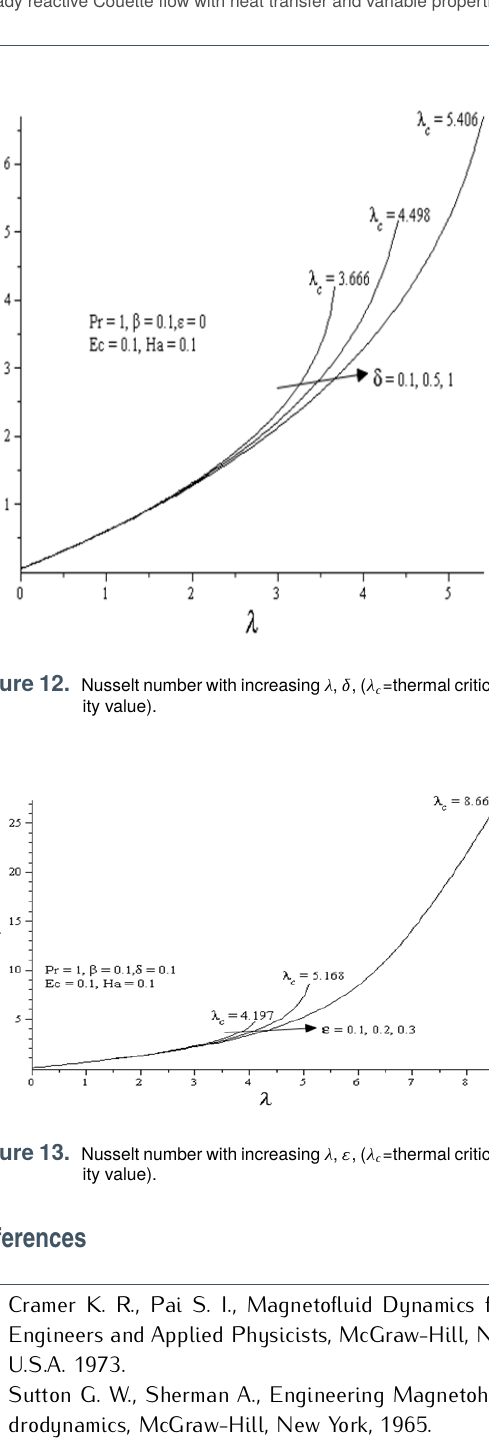
c =thermal critical-